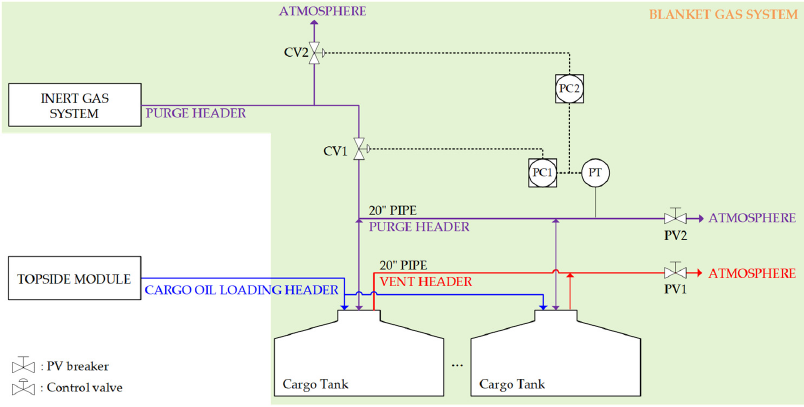
Figure 3. Configuration of a novel blanket gas system (Case B).